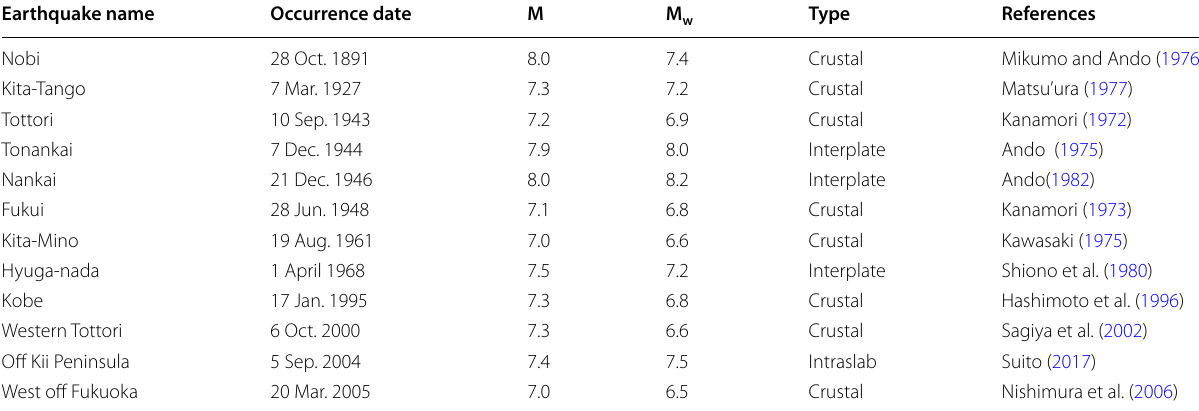
* Moment magnitude assuming a rigidity of 30